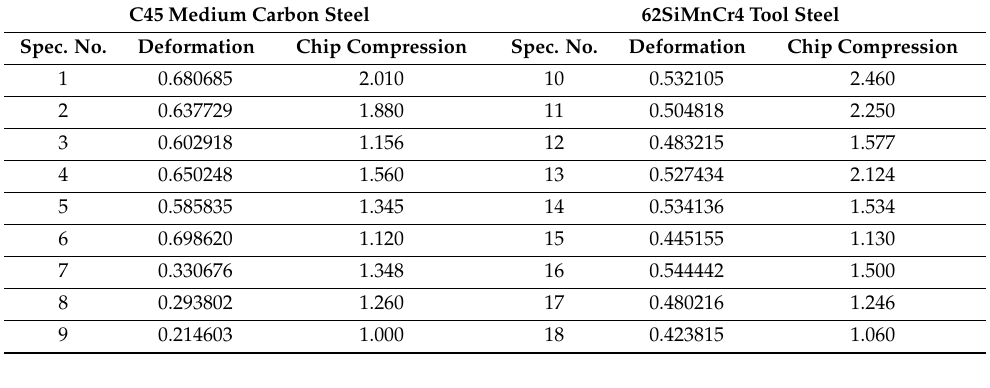
Figure 7. Test lines Placed perpendicular and parallel to the grain boundaries.